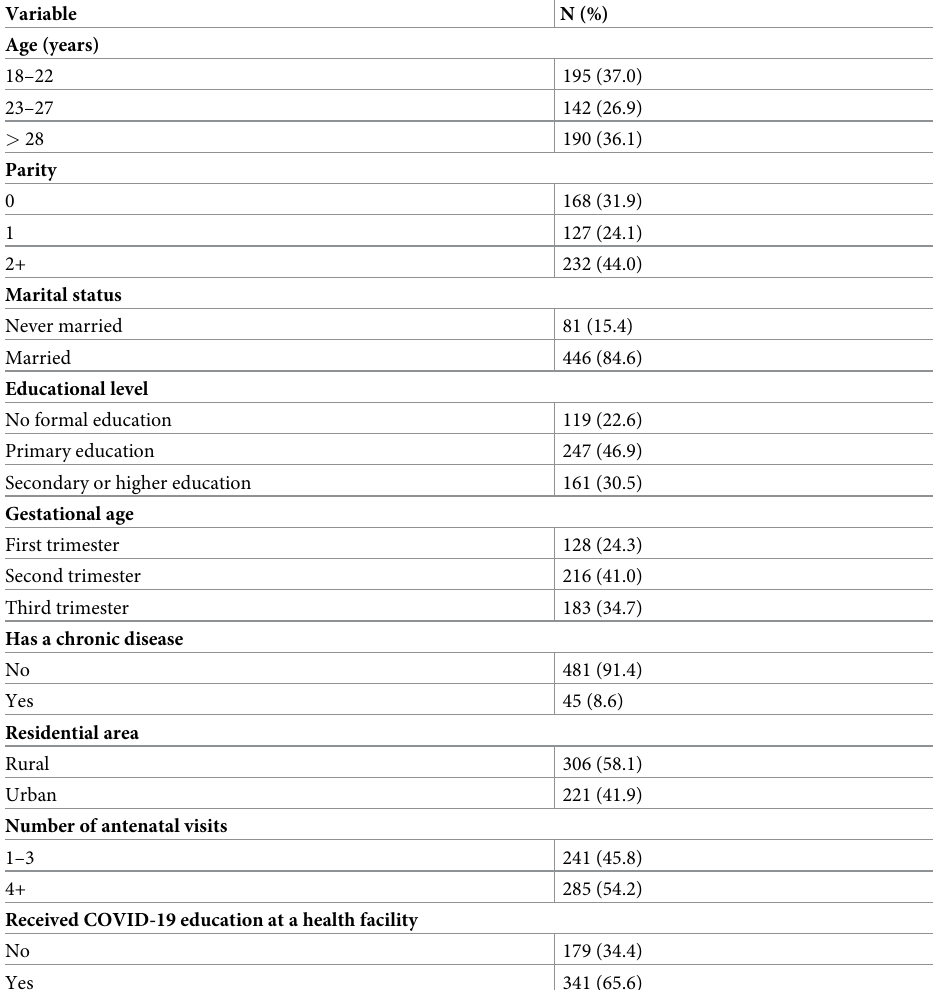
Table 1. Characteristics of the study sample (n =